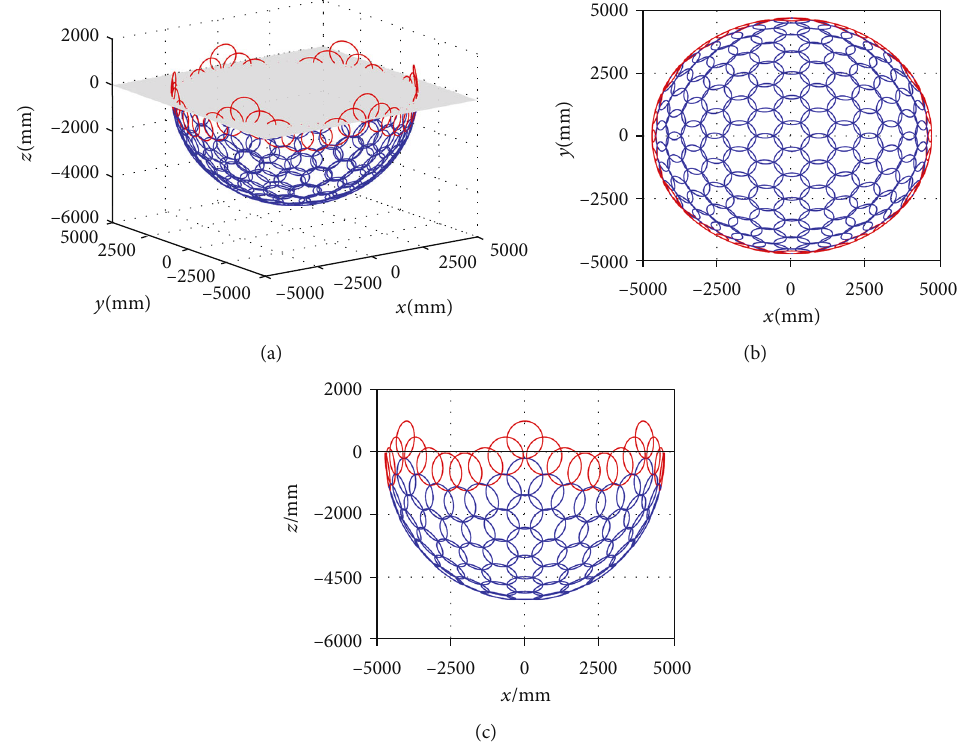
Figure 18: Envelope circle model with eight layers (including 169 envelope circles): (a) 3D view, (b) xoy view, and (c) xoz